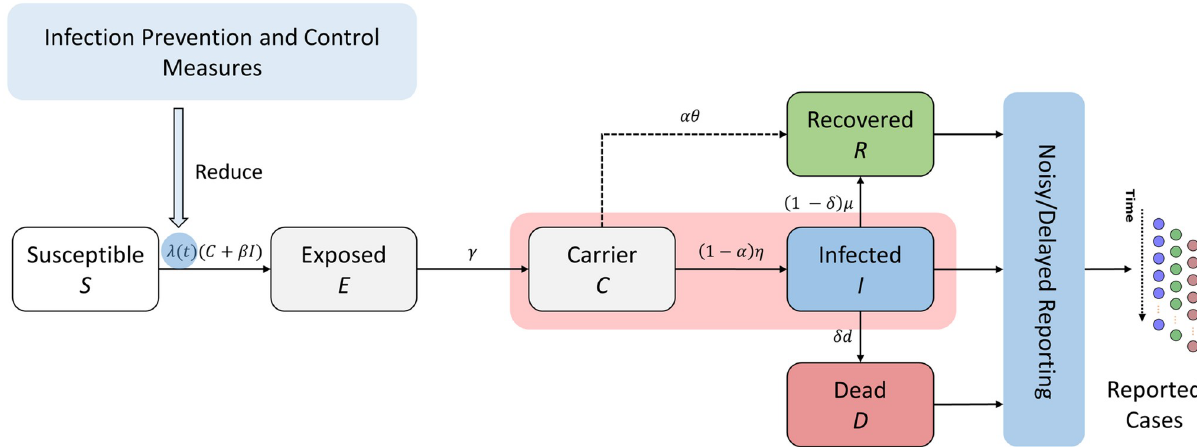
Fig 2. Sketch of the mathematical model describing the epidemiological dynamics of Covid-19. The model is of SEIR-type with six compartments: susceptible ( S ), exposed ( E , i.e. infected but non-infectious), carrier ( C , i.e. infectious but undetected), infected ( I , i.e. infectious and diagnosed), recovered ( R ) and dead ( D ) individuals. In addition, the blue boxes indicate model extensions accounting for external factors, namely intervention measures affecting the transmission rate λ ( t ) and imperfect case reporting due to noise or delays. Note, that data is only reported for the observable compartments I , R , and D . For a detailed description of the model and the different components see Materials and methods.